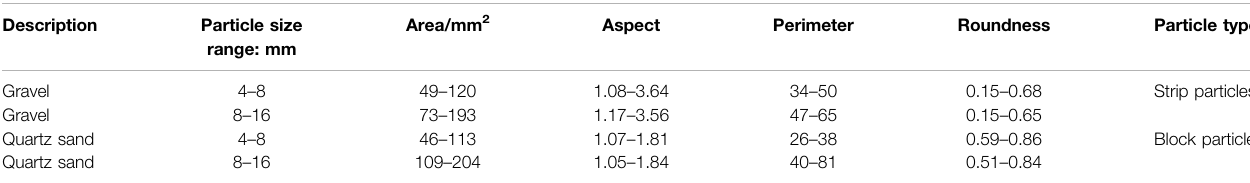
TABLE 1 | Physical parameters of the Gravel and Quartz